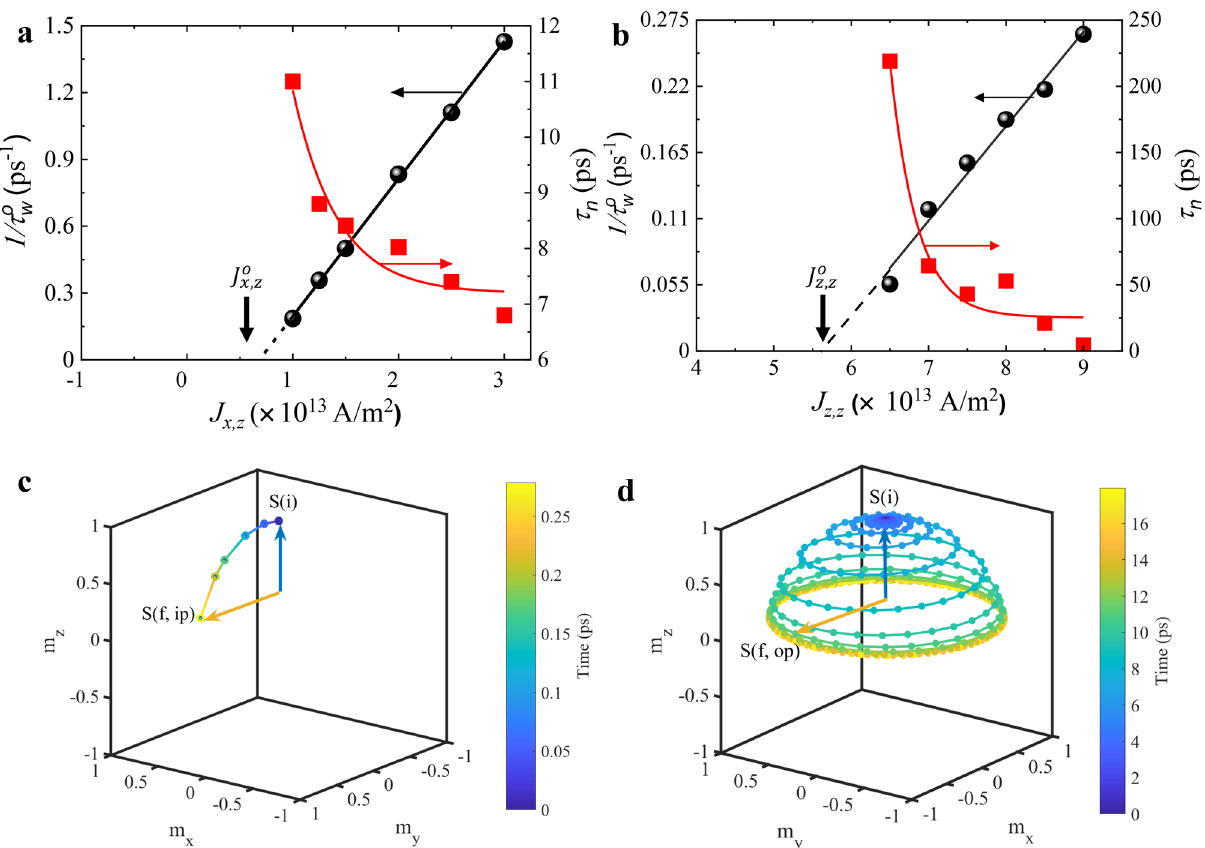
Figure 3. Dependence of inverse of threshold pulse width (black circles) and nucleation time (red squares) on the current density for ( a ) in-plane, and ( b ) out-of-plane spin polarized cases. The trajectory of single AFM moments at fixed current density ( J x , z The color in ( c ) and ( d ) represents time elapsed and t